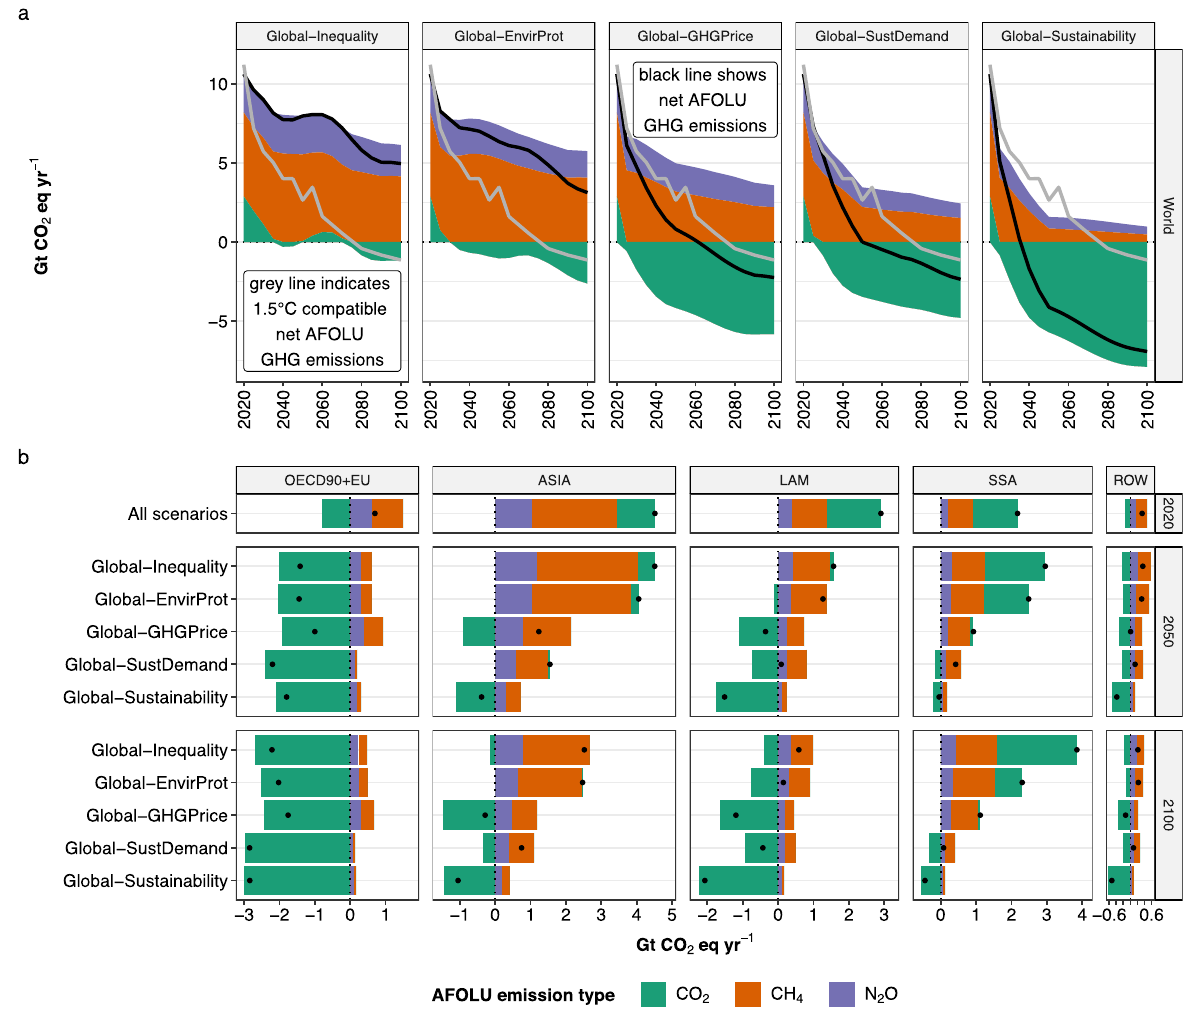
Fig. 6 | AFOLU GHG emissions over time for fi ve scenarios. a shows results at global level over time. b shows results at regional level for 2020, 2050, and 2100. Blacksolidlinesin a anddotsin b showtheneteffectacrossAFOLUGHGemissions. Gray solid lines in a show median values across 1.5°C compatible illustrative miti- gation pathways (LD, Ren, SP) from the IPCC AR6 Scenarios Database 24 . CO 2 includes emissions from land-use change such as deforestation and conversion